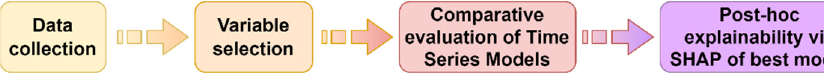
Figure 3. The four main steps of the methodology.